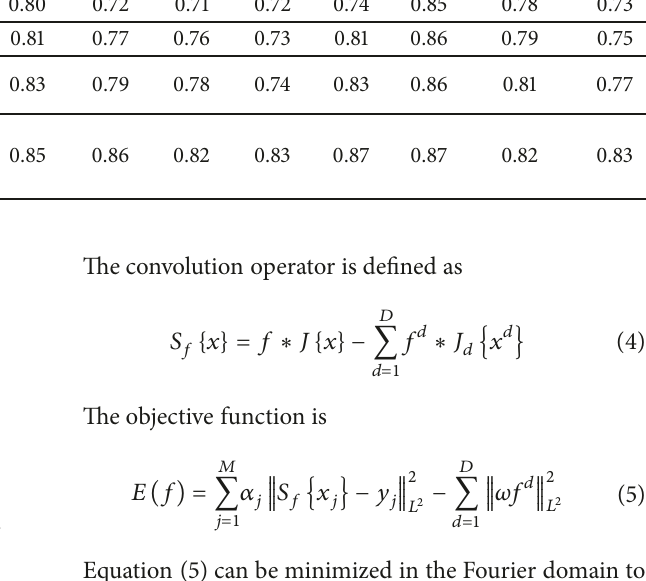
Table 1: Comparison results: SR using different deep features fusions on the PTB dataset. Deep